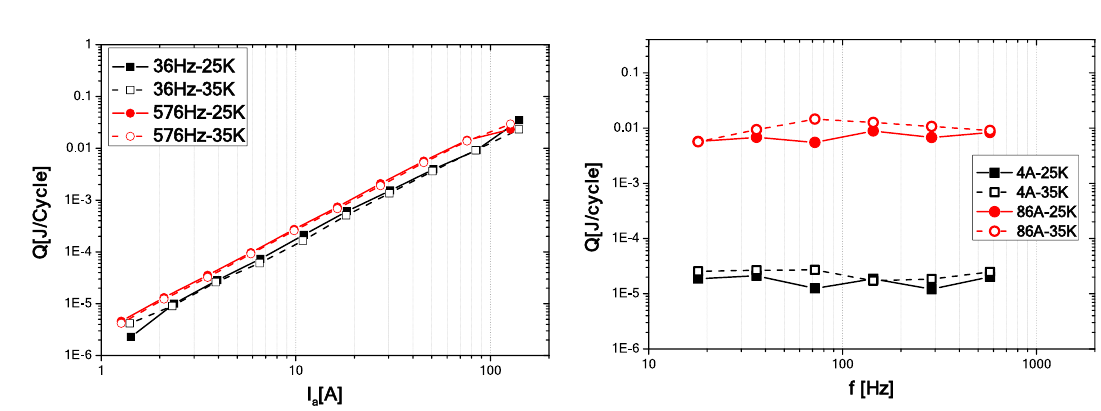
Figure 6. Comparison of coil AC loss dependence versus transport current and frequency, measured at temperatures 25 K and 35